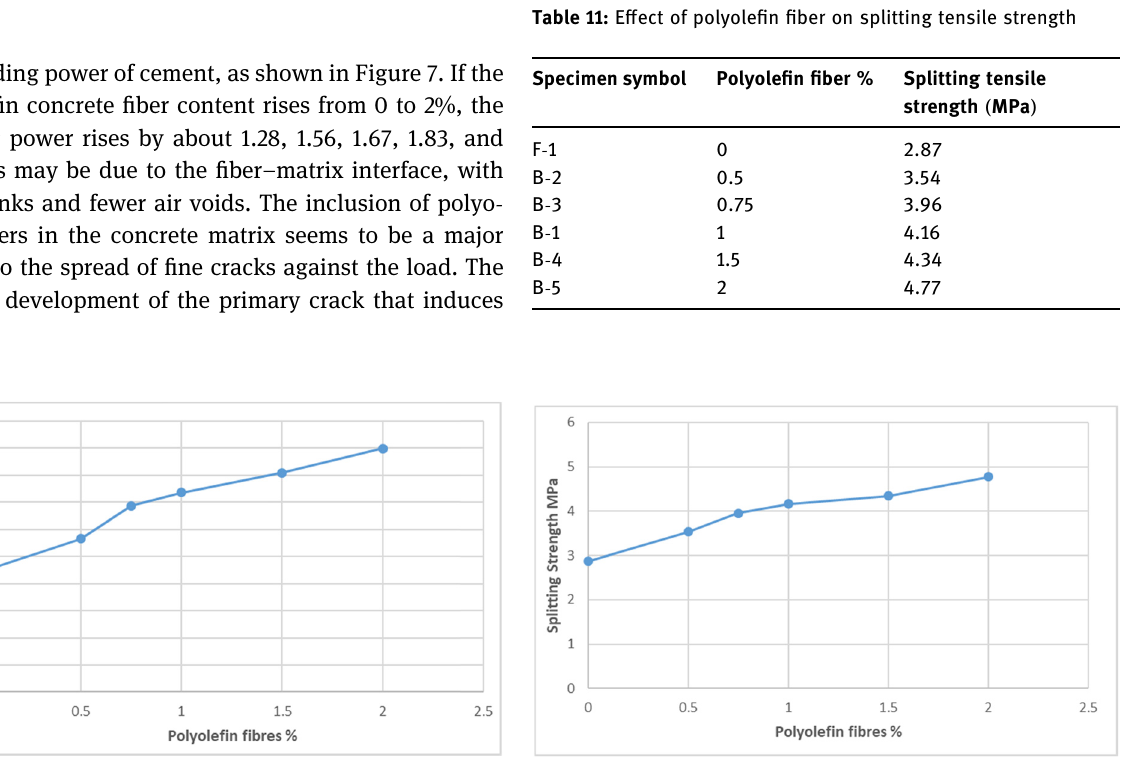
Figure 8: Splitting tensile strength of concrete containing polyole fi n % in di ff erent